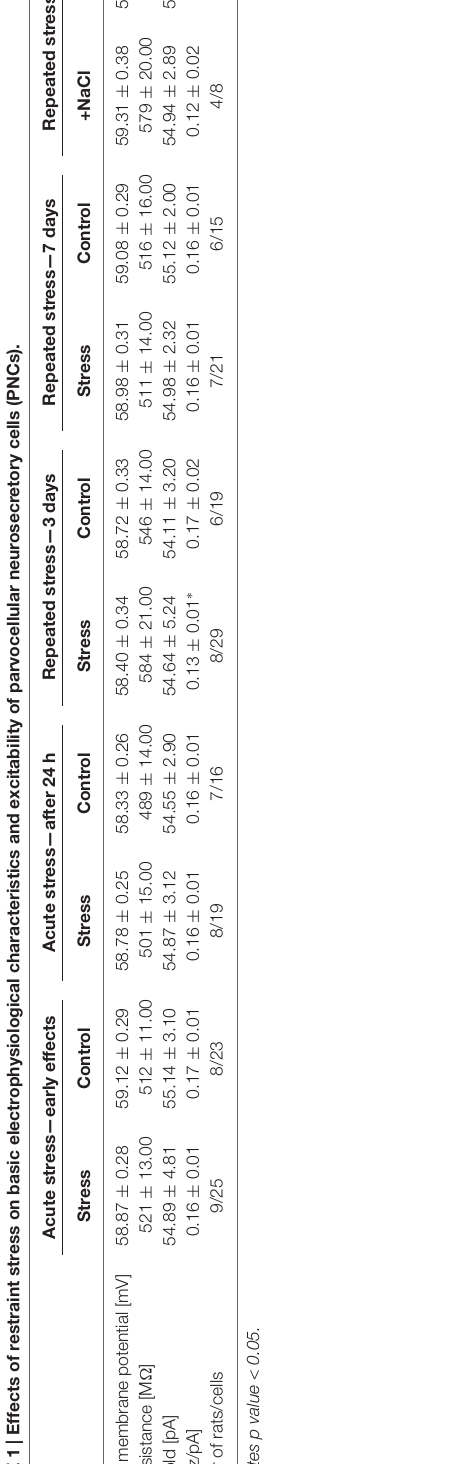
between cells from stressed and control rats (15.13 ± 0.58 vs. 15.08 ± 0.54 pA, respectively; t = − 1.482, df = 21, p = 0.15; Figure 3A 3 ). The rise time (0.99 ± 0.03 vs. 1.08 ± 0.03 ms, t = 0.833, df = 21, p = 0.412) and the decay time constant